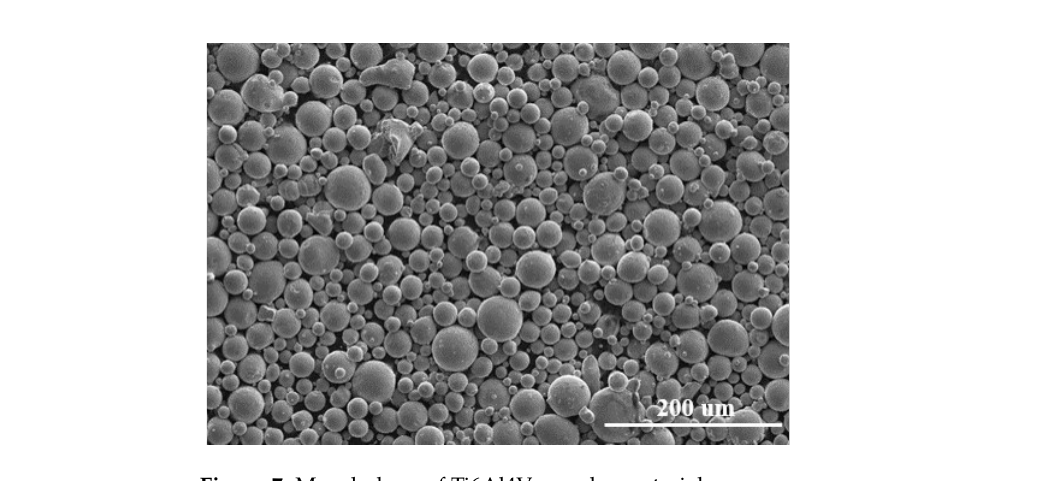
Figure 6. Particle size distribution of Ti6Al4V powder material.